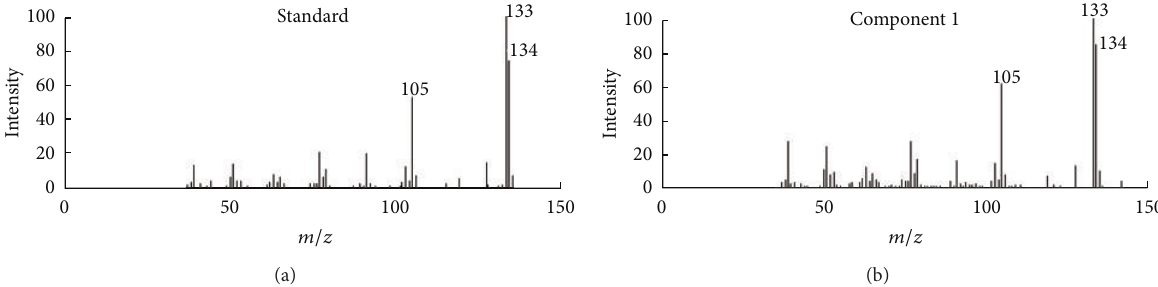
Figure 3: Resolved mass spectrum of component 1 by SFA and standard mass spectrum of